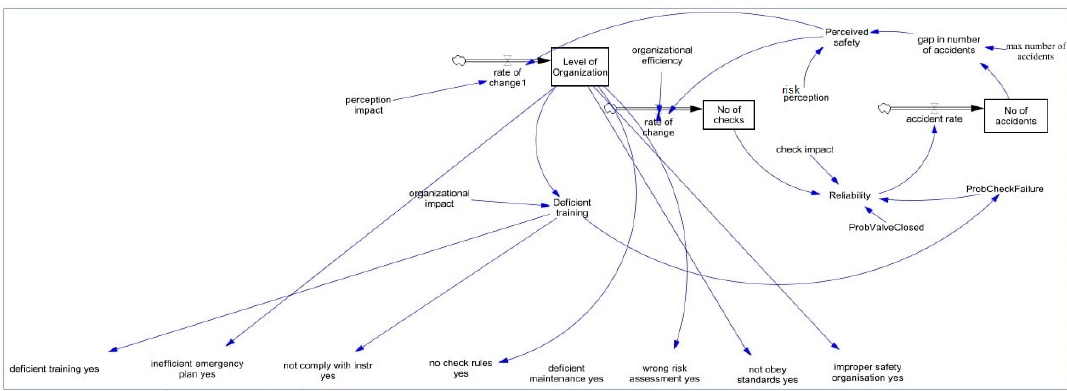
Figure A2 System adaptation models. Figure A2. System adaptation